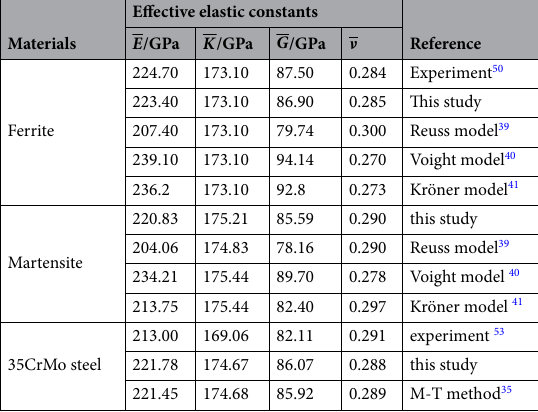
Table 5. Calculated and experimental values of effective elastic